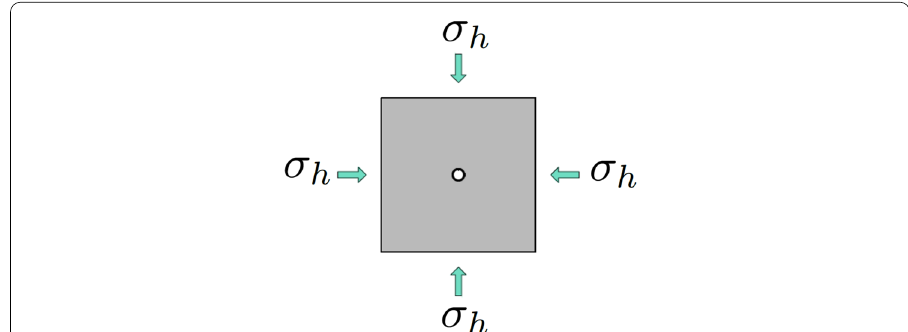
Fig. 7 Diagram of explosively loaded wellbore problem